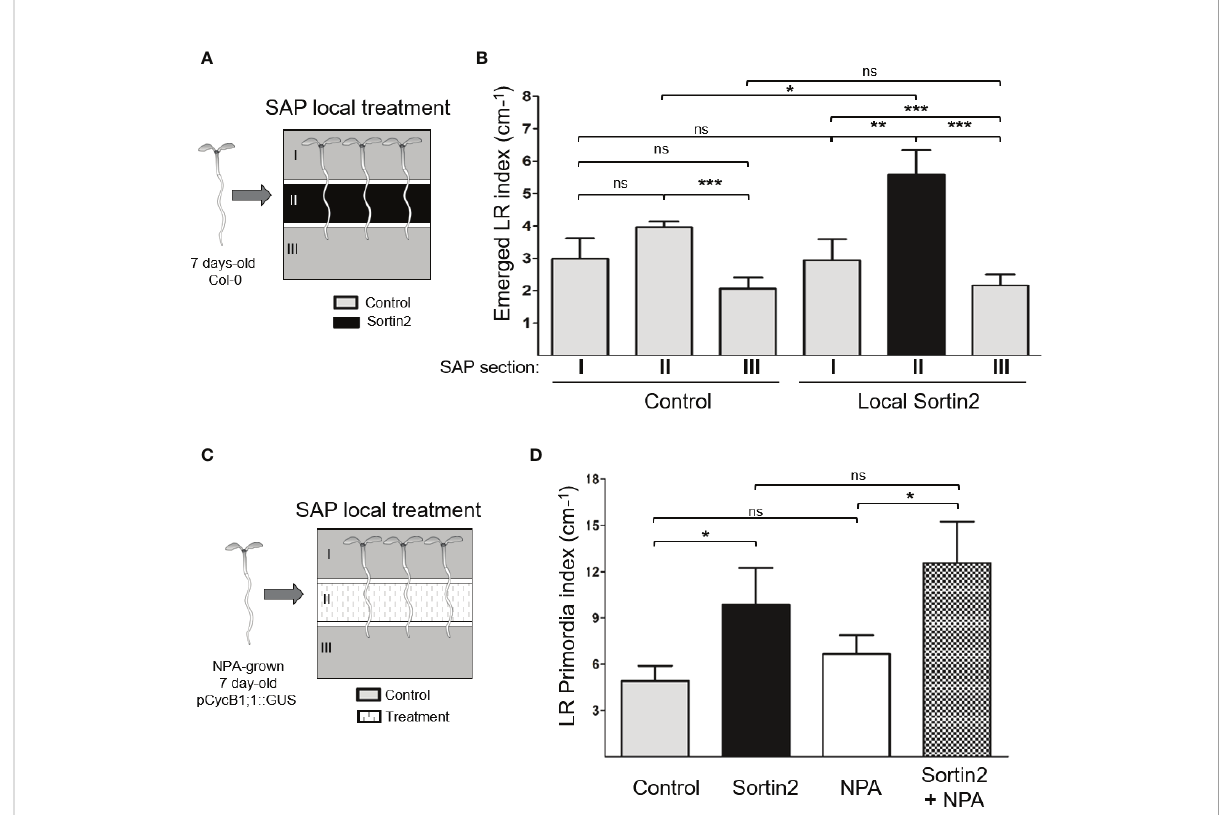
FIGURE 3 Induction of endomembrane traf fi cking toward the vacuole induces differentiation of pericycle cells to lateral root founder cells. (A) Segmented agar plates (SAPs) were used for local treatments, as illustrated schematically. Section II contained growth medium with Sortin2 (local Sortin2) or DMSO (1%; control), while sections I and III contained growth medium with DMSO. Sections were separated by 2 mm of air. Seven-day-old wild-type (Col- 0) seedlings were transferred to SAPs. (B) After 6 days, the emerged lateral root of these seedlings were quanti fi ed on each SAP section. The assay was performed in triplicate ( n ≥ 29 seedlings). (C) SAPs were established with growth medium supplemented with Sortin2, NPA (10 µM), Sortin2 plus NPA, or DMSO (1%) in section II; sections I and III contained medium with DMSO. Then, seven-day-old NPA-grown p CYCB1;1 ::GUS seedlings were transferred to the plates. (D) After 6 days, the GUS-positive lateral root primordia that developed in section II were quanti fi ed. Results from three experiments ( n = 14 [Control], 13 [Sortin2], 8 [NPA], 11 [NPA+Sortin2] seedlings) are shown. (B, D) Results were analyzed by Student ’ s t -tests; brackets denote statistical differences between conditions (* p < 0.05; ** p < 0.01; *** p < 0.001; ns, not signi fi